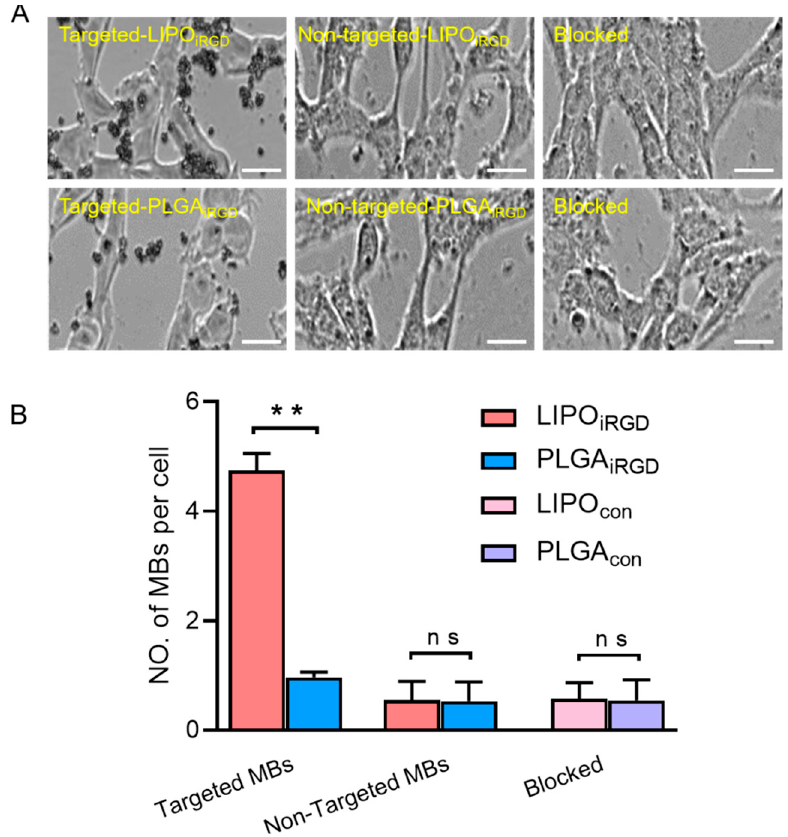
Figure 3. Binding ability of MBs to bEnd.3 cells. ( A ) In vitro cell binding of LIPO iRGD and PLGA iRGD to bEnd.3 cells. Blocked group indicates the bEnd.3 cells were pre-blocked with free anti-av antibody. ( B ) Quantitative analysis of the number of three groups of LIPO iRGD and PLGA iRGD that adhered onto bEnd.3 cells from five random view fields (** p < 0.01, n = 5). Scale bar = 10 µm. Data were analyzed by independent sample t -test (** p < 0.05, ns means p > 0.05).